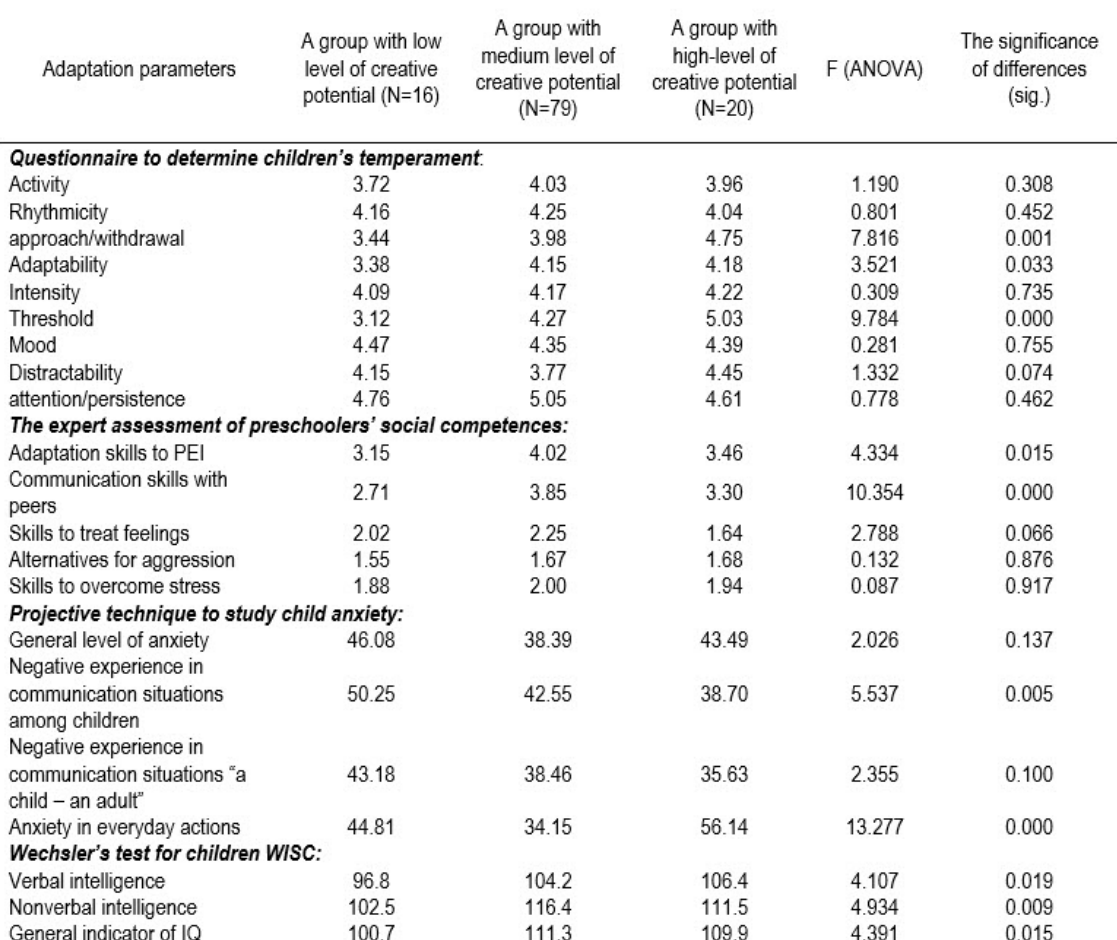
The comparative analysis of the average adaptation indicators in groups of preschoolers with different creative